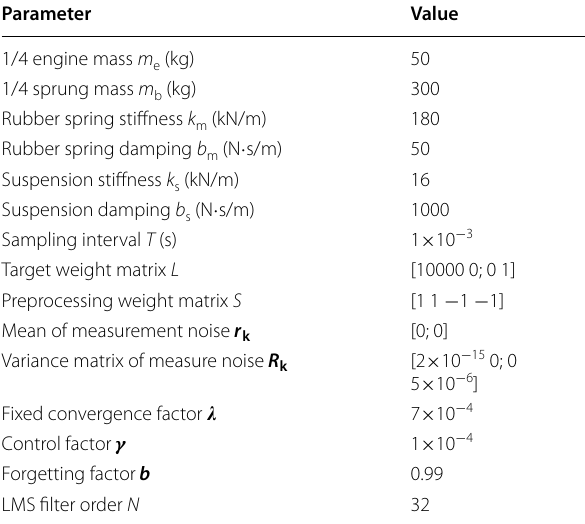
Table 2 Parameters of two-degree-of-freedom active mounting system